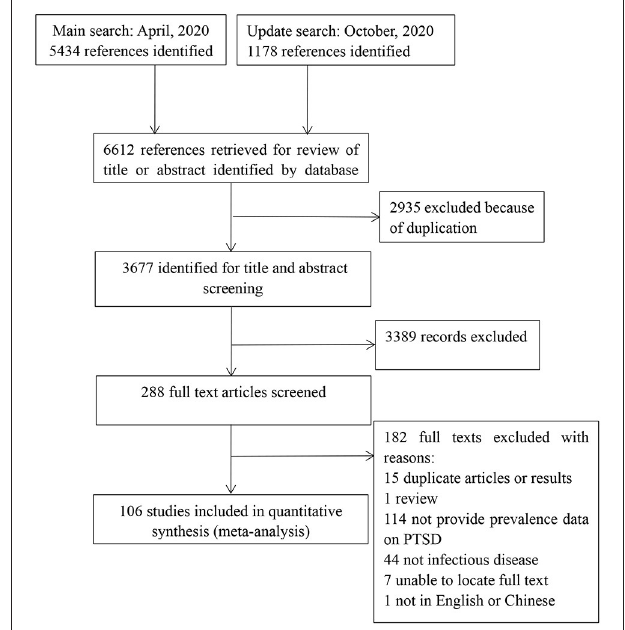
FIGURE 1 | Flow of studies through